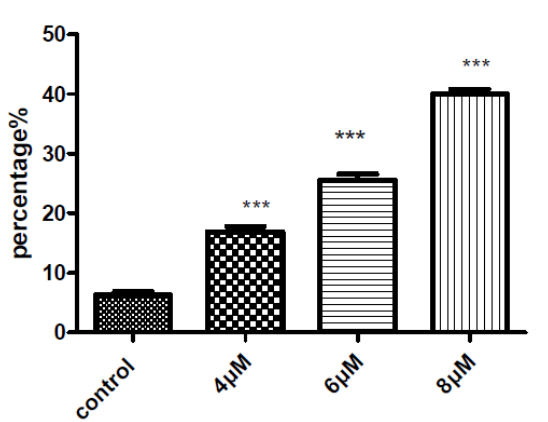
Values are expressed as a 9.